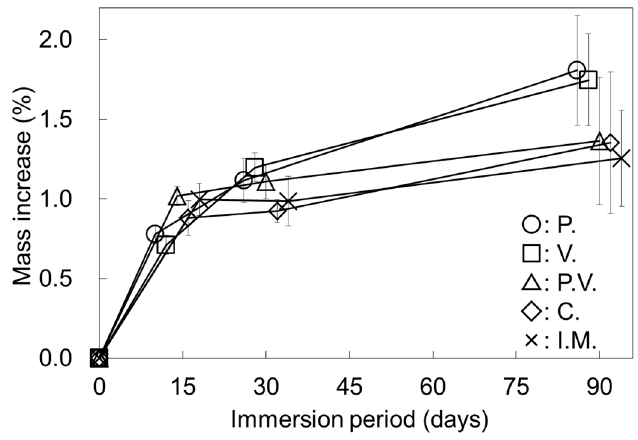
Figure 12. Comparison of the mass increases of the five test piece types. Average ± S.D., n = 5 for 15 days, and n = 10 for 30 and 90 days of immersion.